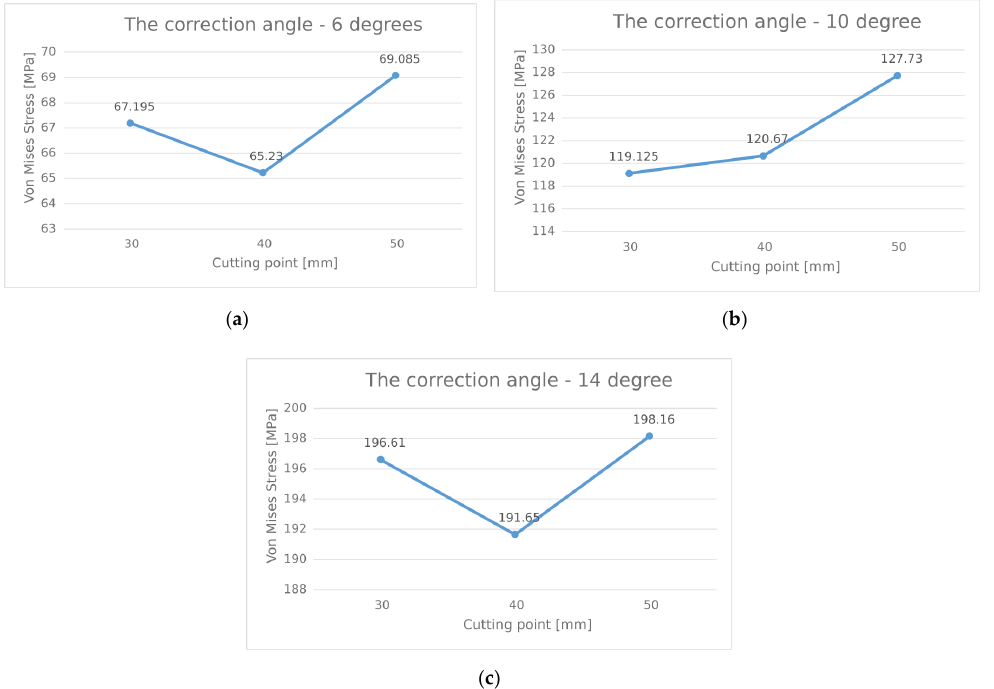
Figure 13. Variation of von Mises stresses in relation to the position of the cutting point. ( a ) 6 degree; ( b ) 10 degree; ( c ) 14